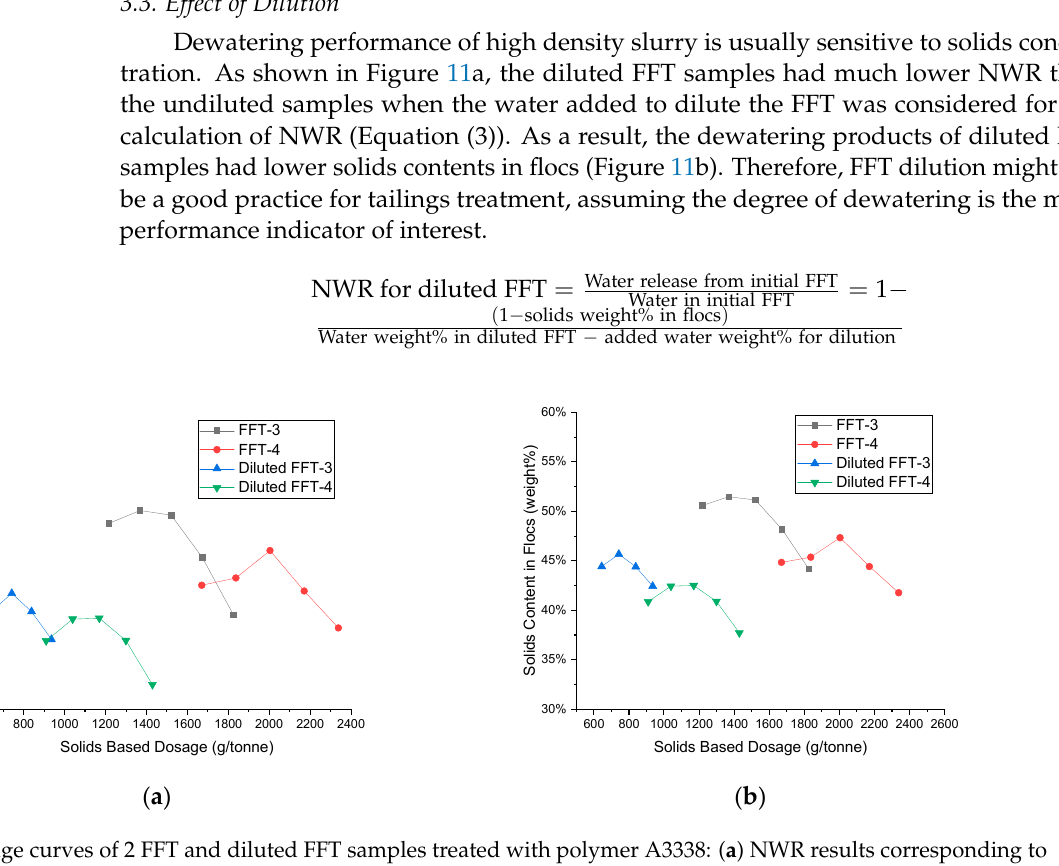
Figure 10. The influence of geometry of mixers on flocculation: ( a ) torque readings by flat mixer and auger mixer during the flocculation of FFT-4 with polymer A3338; ( b ) dosage curves of three FFT samples flocculated by A3338 using flat mixer and auger mixer, respectively. Each dot is the average value of duplicate or more testing results in ( b ).